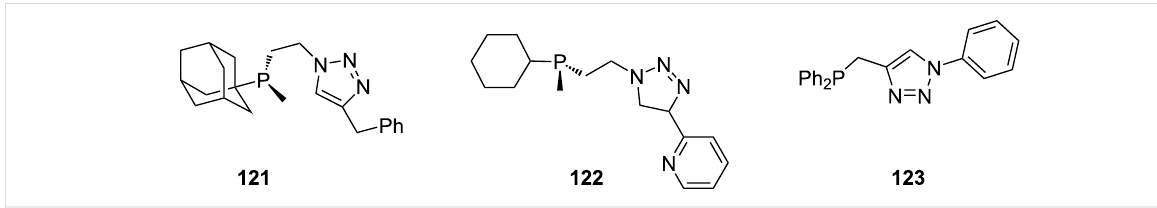
Figure 2: Triazolylphosphanamine ligands synthesized by Wassenaar’s method [22].